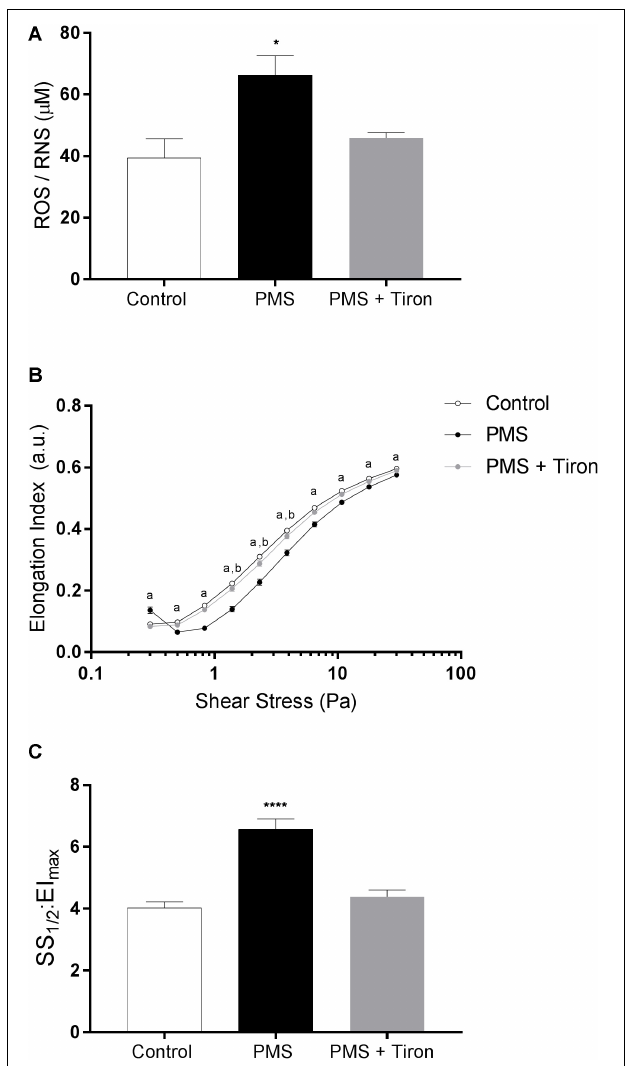
FIGURE 1 | The concentration of total reactive oxygen species (ROS) increased in phenazine methosulfate-treated cells (PMS) compared to control red blood cells (RBC; A ). Concurrent incubation with PMS and Tiron decreased total ROS to Control levels. RBC elongation indices (EI), quantified over a range of shear stresses (0.3–30 Pa), were decreased in PMS-treated RBC when compared to control; Tiron partially prevented impaired deformability (B) . A global parameter of cell deformability was also impaired in PMS-treated RBC compared to control (C) , although Tiron reversed this effect. a Control significantly different to PMS. b Control different compared with PMS + Tiron. ∗∗∗∗ p < 0.0001 significantly different to Control. ∗ p < 0.05 significantly different compared to Control.